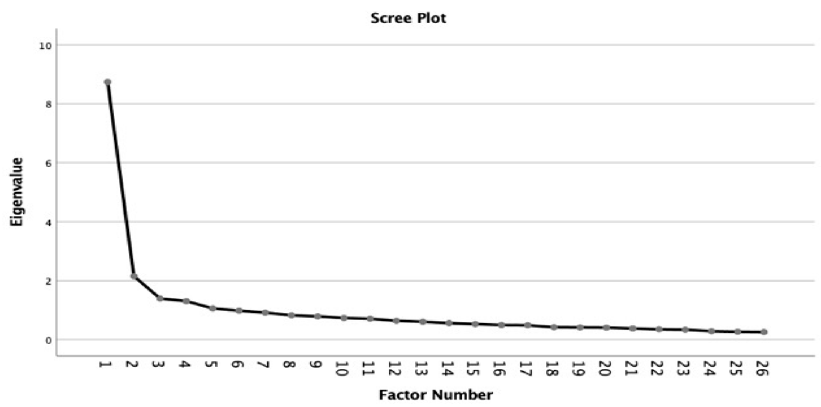
Figure 1. EFA Scree-plot.